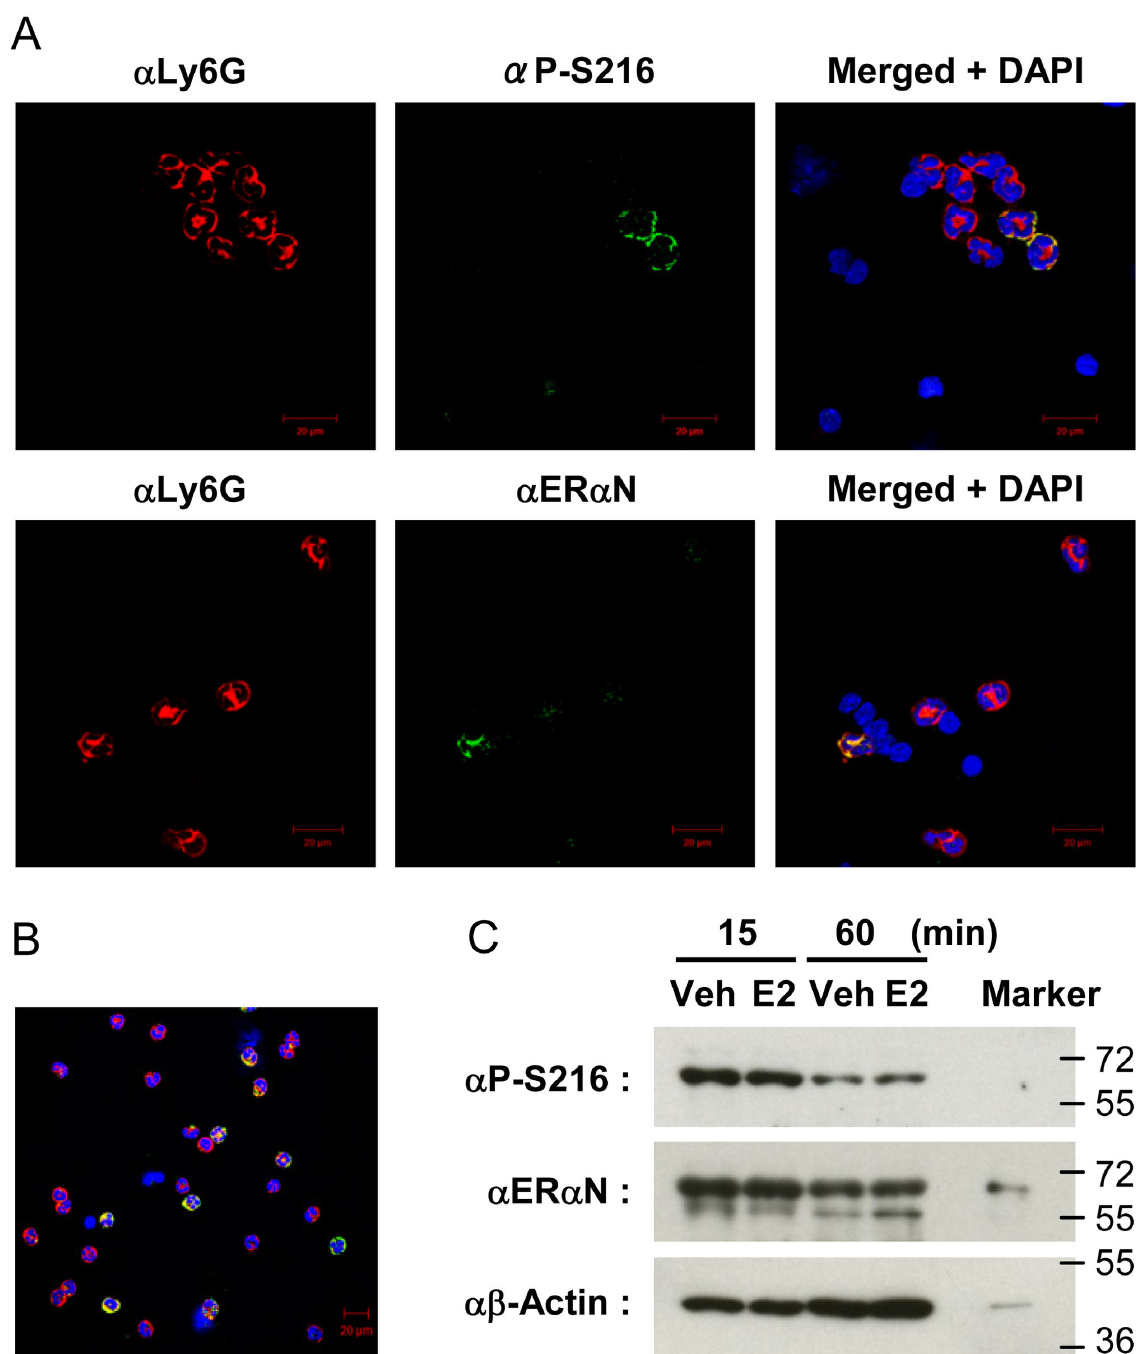
Figure 4. Phosphorylated ERα in peripheral blood and peritoneal neutrophils. (A) WBC were isolated from peripheral blood collected from female mice for double staining with an anti-Ly6G antibody (αLy6G) and either an anti-P-Ser-216 (αP-S216) or an anti-ERαN (αERαN) antibody. Staining and nuclei were visualized as described in the legend of Figure 2. (B) Peritoneal neutrophils were prepared on slides as described in the Materials and Methods section and double stained by αLy6G (in red) and that by αP- S216 (in green). This picture overlaps the double antibody staining with DAPI staining. (C) Peritoneal Neutrophils were cultured with ethanol (vehicle) or estradiol (E2, 10 nM) for 15 or 60 min at 37 °C, from which whole extracts were prepared for Western blots with αP-S216, αERαN or anti-β-Actin (αβActin) antibody. Whole extracts that contained recombinant human ERα (not phosphorylated) was utilized as an ERα marker. αβActin staining endogenous actin was utilized to verify equal amounts of proteins in each well. doi: 10.1371/journal.pone.0084462.g004 PLOS ONE |